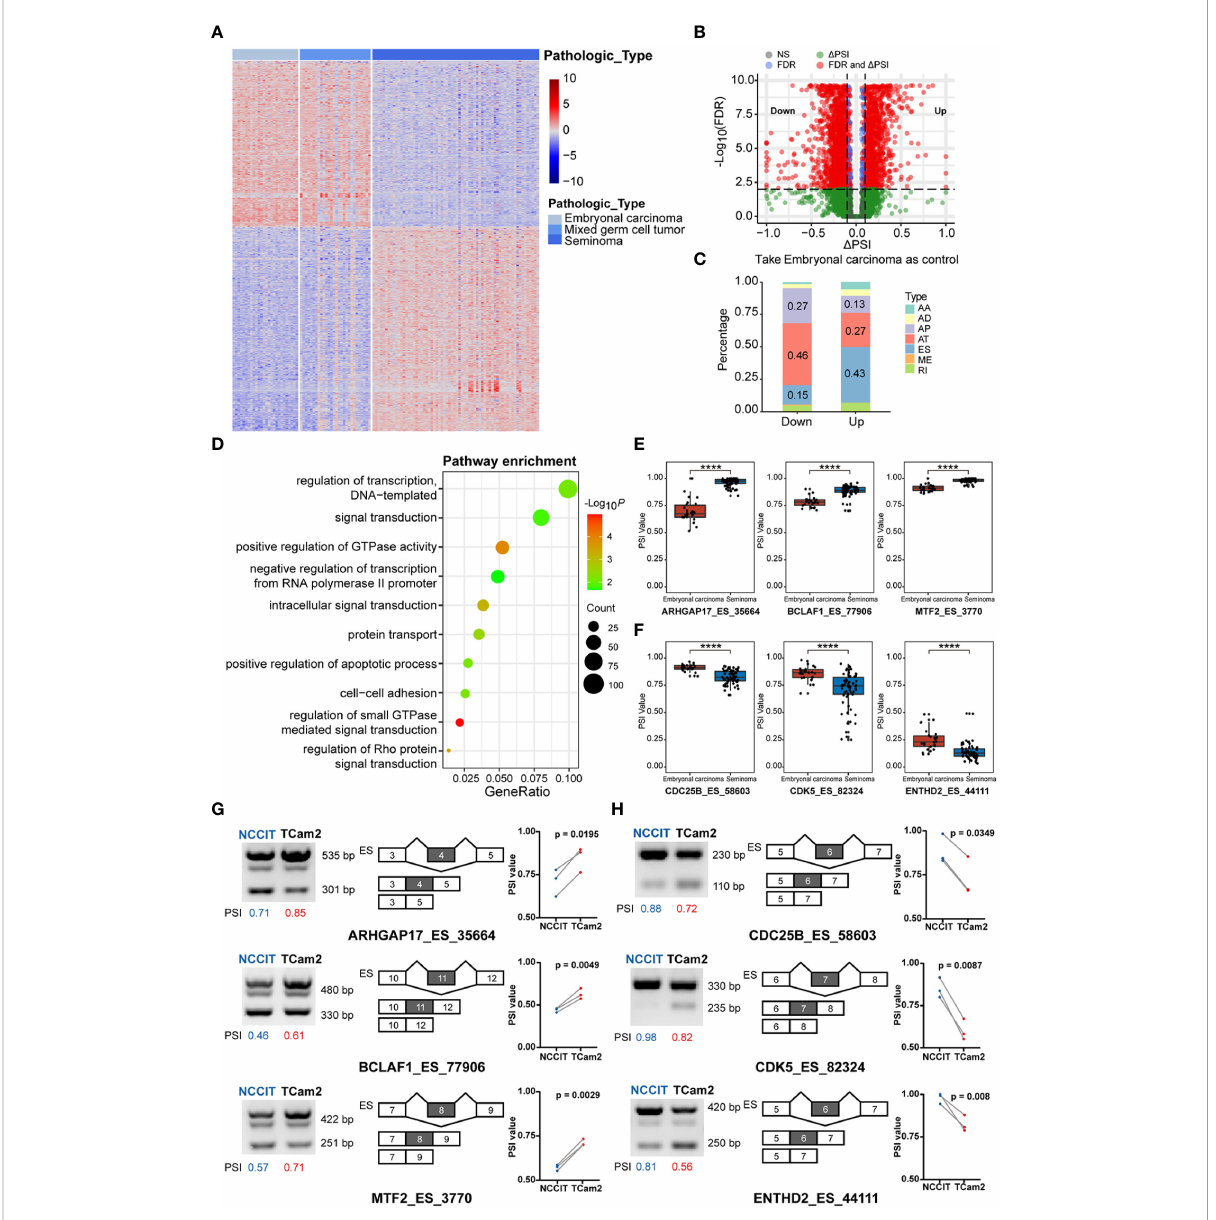
FIGURE 2 The difference in alternative splicing (AS) between TGCT subgroups. (A) Kruskal-Wallis test was performed to analyze the difference in AS events between embryonal carcinoma, mixed germ cell tumor and seminoma (top 1000 events, FDR<0.05). (B) Wilcoxon rank-sum test and delta median PSI value was used to analyze the difference between embryonal carcinoma and seminoma (FDR<0.05, delta PSI>0.1). Take embryonal carcinoma as control. Up: Splicing events with higher PSI values in seminoma than in embryonal carcinoma; Down: Splice events with lower PSI values in seminoma than in embryonal carcinoma. (C) The percentage bar graph showed the difference in splicing types between the up and down groups. (D) GO term enrichment of differentially spliced (DAS) genes. (E, F) Comparison of PSI values for differential AS events in two subtypes. (G, H) Differential expression of spliced transcripts was validated in the TGCT cell lines through semi-qPCR and corresponding agarose gel electrophoresis. Calculate the PSI of each lane by dividing the gray value of the longer transcript by the sum of the gray value of the longer and shorter transcripts. **** P <